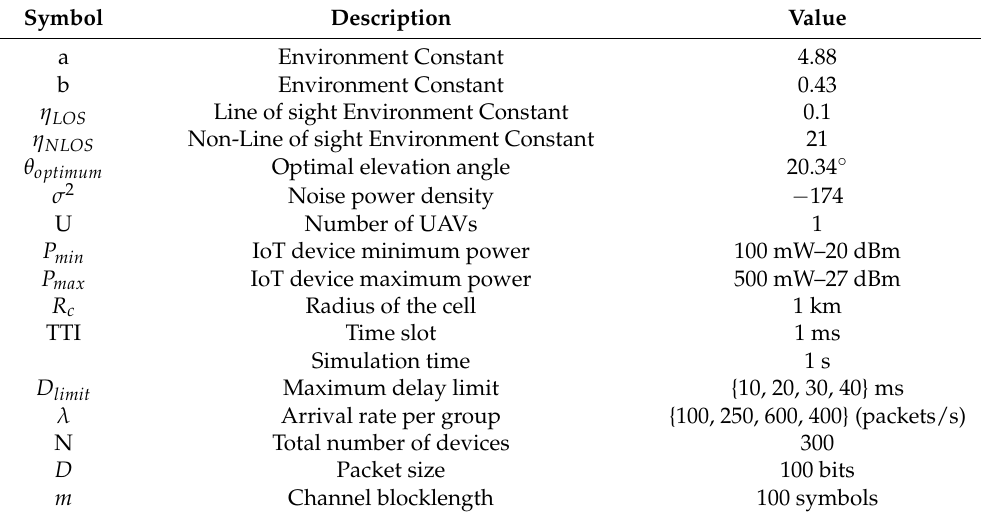
Table 2. Simulation parameters.